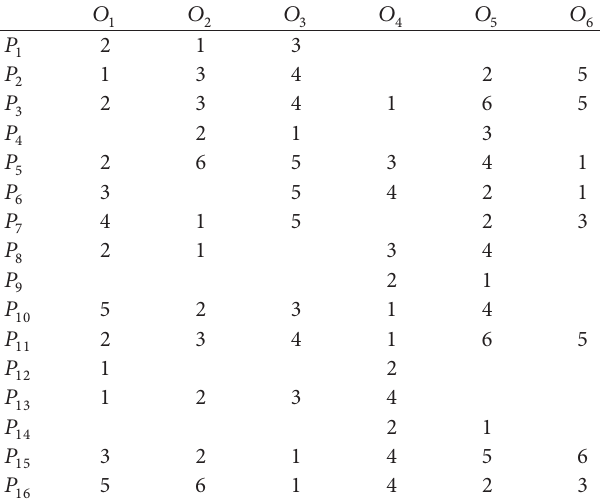
Table 3: The rank of the six objects of Figure 10, obtained from the gaze plots of the 16